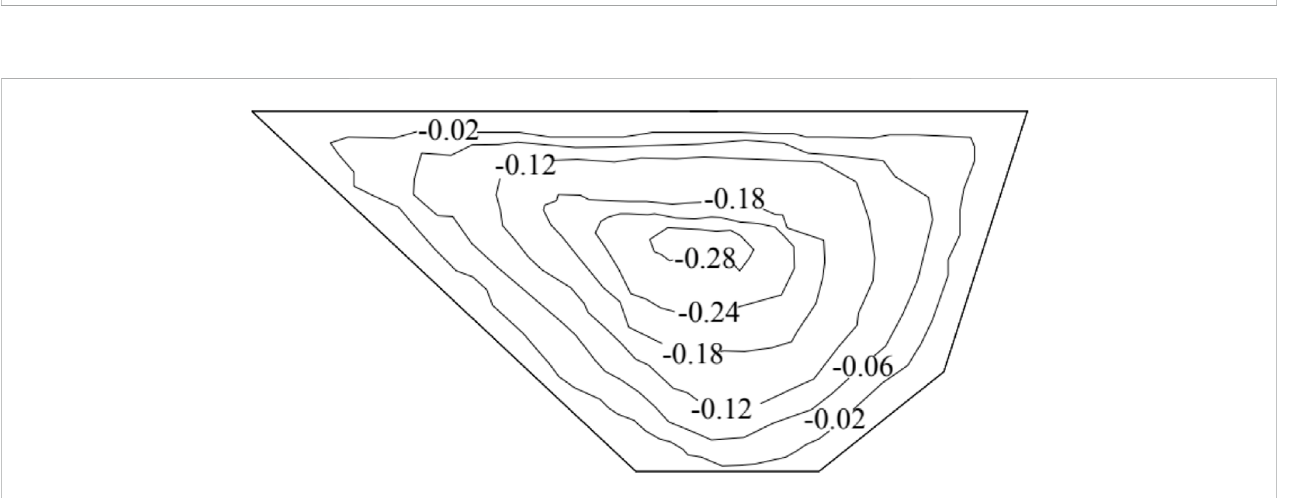
FIGURE 14 Vertical deformation of the extruding side-wall in Completion period (unit: m).